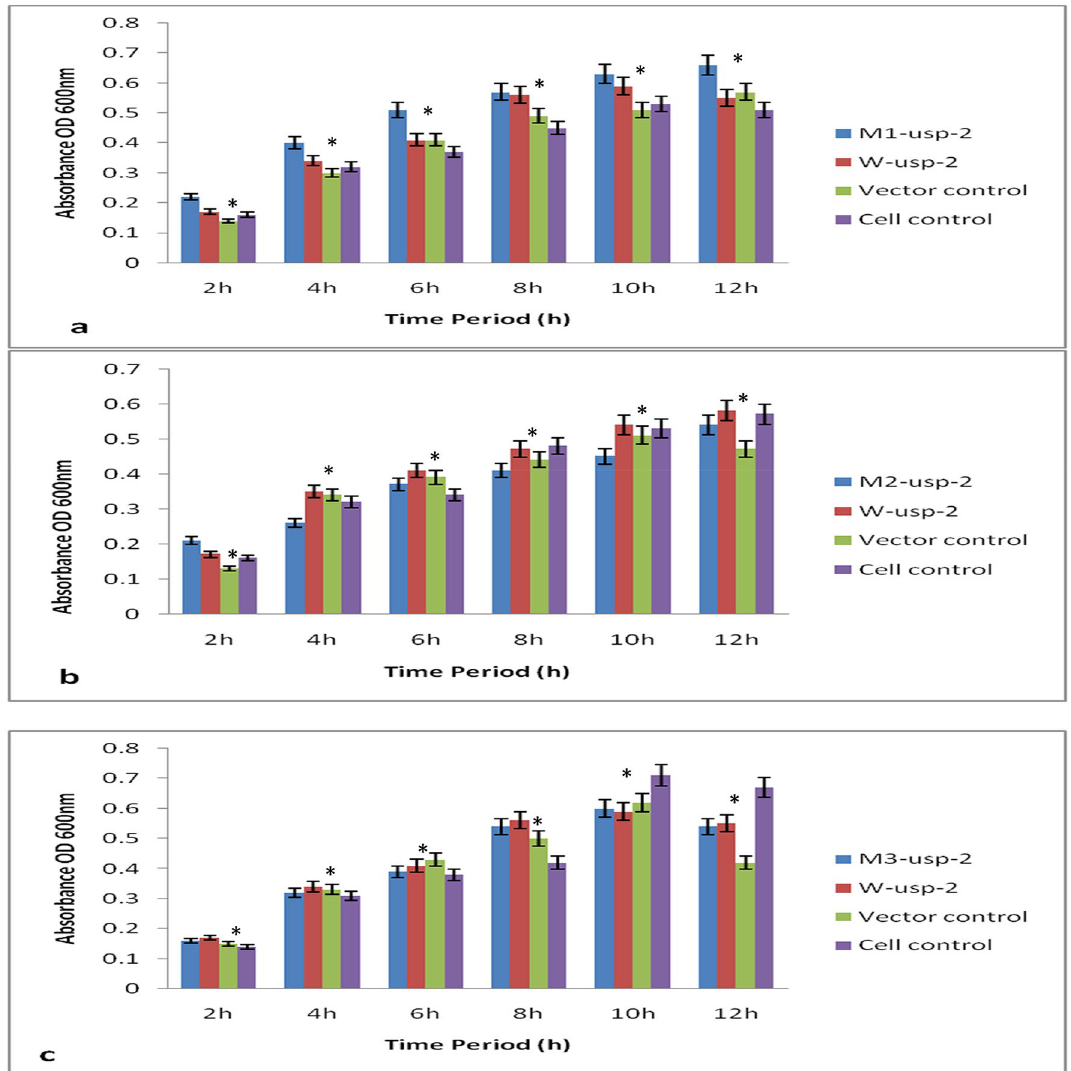
Figure 6. Comparison of Heat stress tolerance in E. coli BL-21 . Both E. coli BL-21-uspABC ( a – c ) cells expressing W-usp-2 , M1-usp-2, M2-usp-2 and M3-usp-2 showed slight tolerance as compared to control. ( b ) W-usp-2 and M3-usp-2 gene expressing BL-21-uspABC cells are modestly tolerant as compared to M2-usp-2 cloned cells. It remained difficult to claim difference of survival rate among wild type and mutant